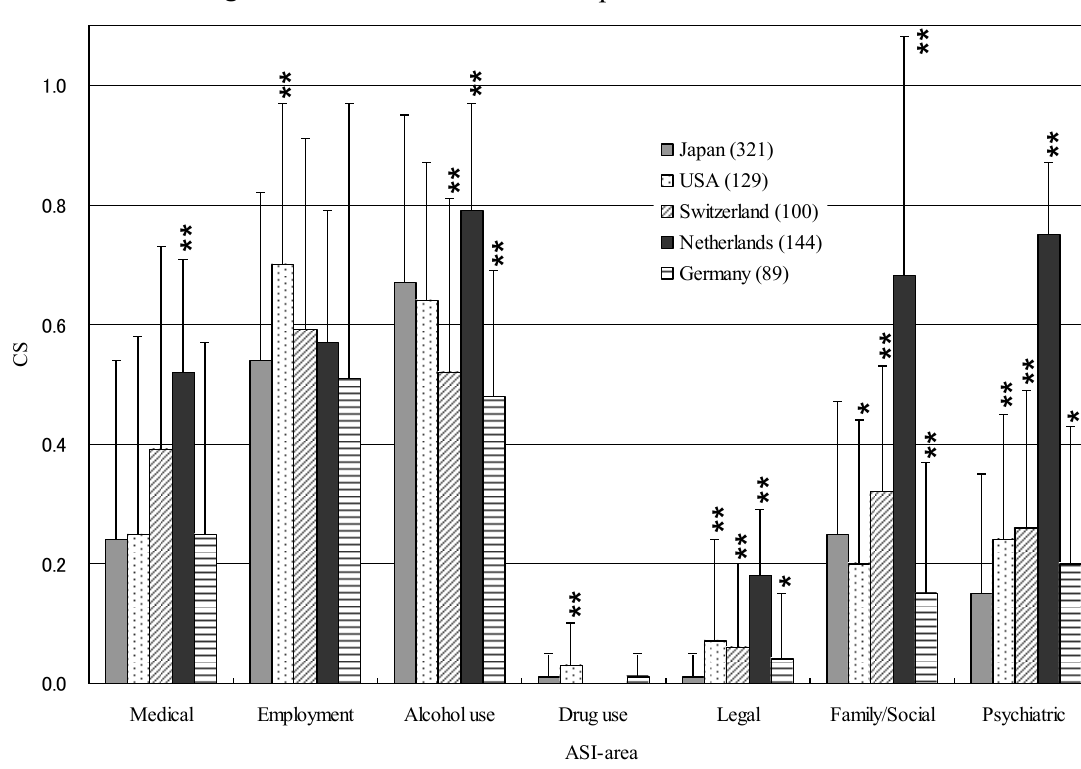
Figure 4. Differences between Japanese data and other